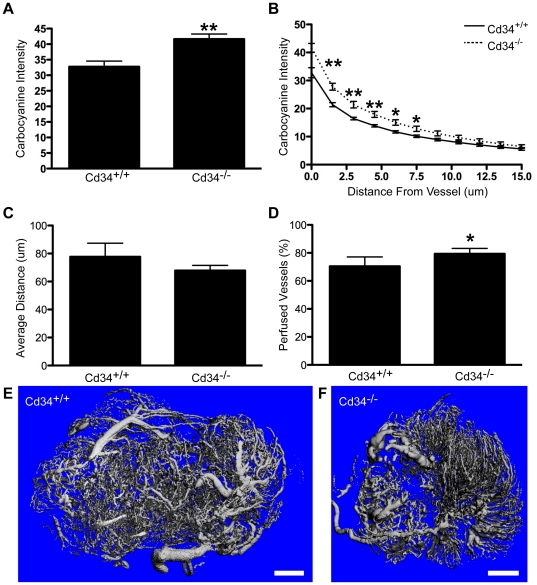
Increased carbocyanine leakage and altered vessel morphology in subcutaneously-injected tumors from Cd34−/− animals.Carbocyanine fluorescence intensity quantified A, proximal to CD31+ vessels (at distance 0 µm) and B, with increasing distance from the nearest vessel (CD31+), in day 14 tumors. C, Average distance of each pixel within the tumor tissue from the nearest CD31+ staining pixel. D, Perfused vessels (%), corresponding to the percentage of CD31+ pixels colocalized with carbocyanine staining. For carbocyanine data, one outlier per genotype was removed prior to analysis. (n = 5 for carbocyanine, n = 6 for average distance, *represents p<0.05; **represents p<0.01; Error bars = SEM). Representative CT images of tumors excised 14 days post-injection and perfused with Microfil contrast reagent from E, Cd34+/+ and F, Cd34−/− mice. Scale bars, 2 mm (n = 3).